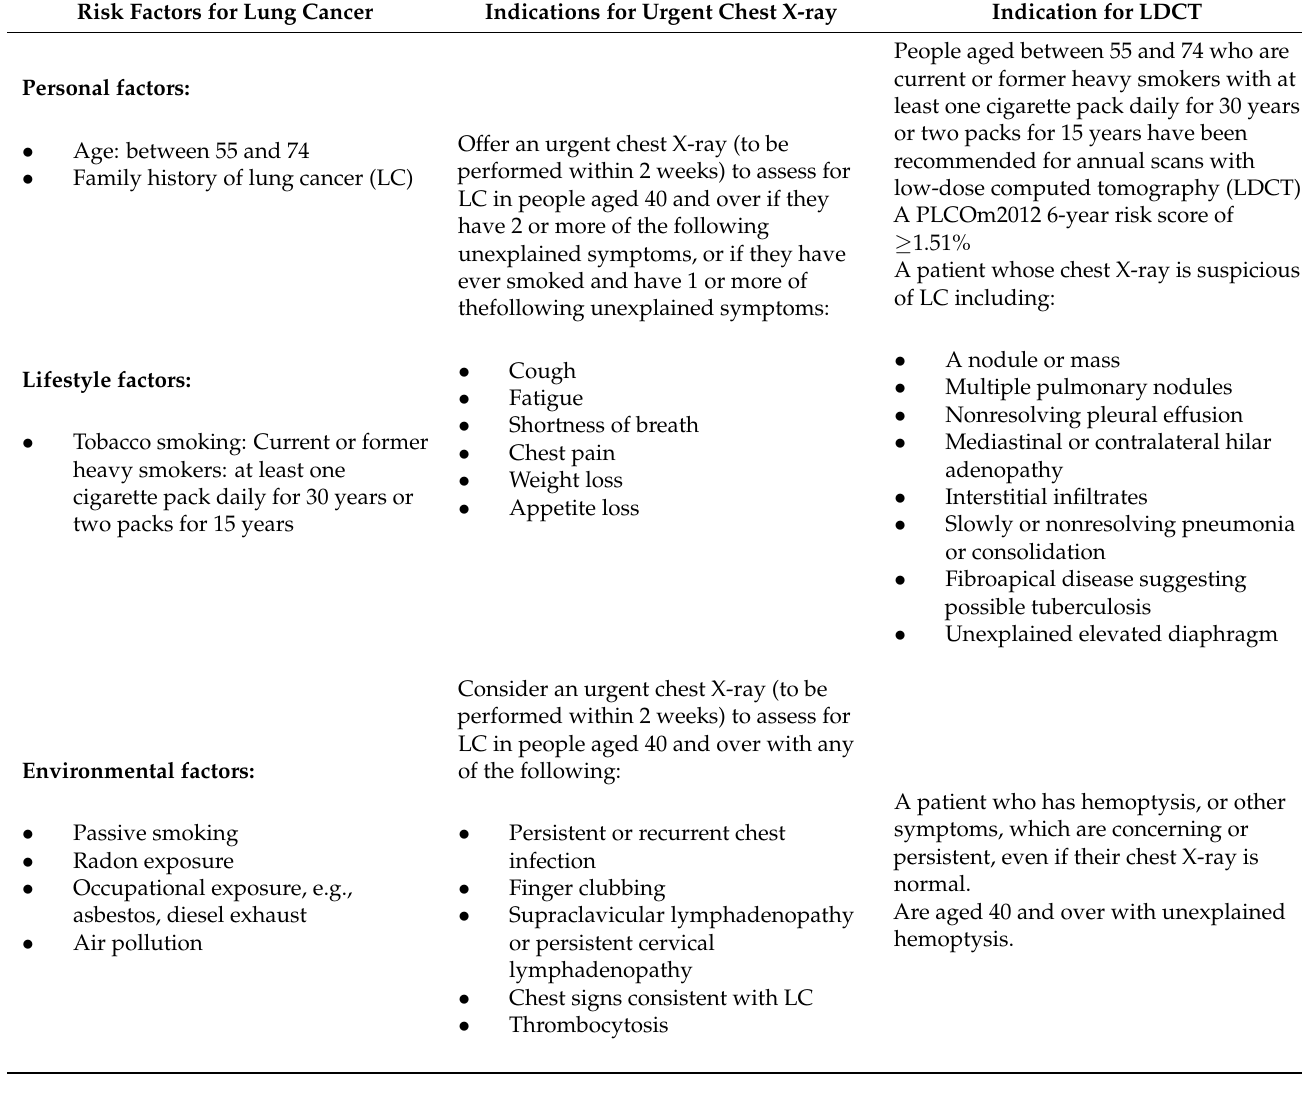
Table 1. Guideline for Screening and Diagnostic Approach [10,20,22,25,29–32]. Risk Factors for Lung Cancer Indications for Urgent Chest X-ray Indication for